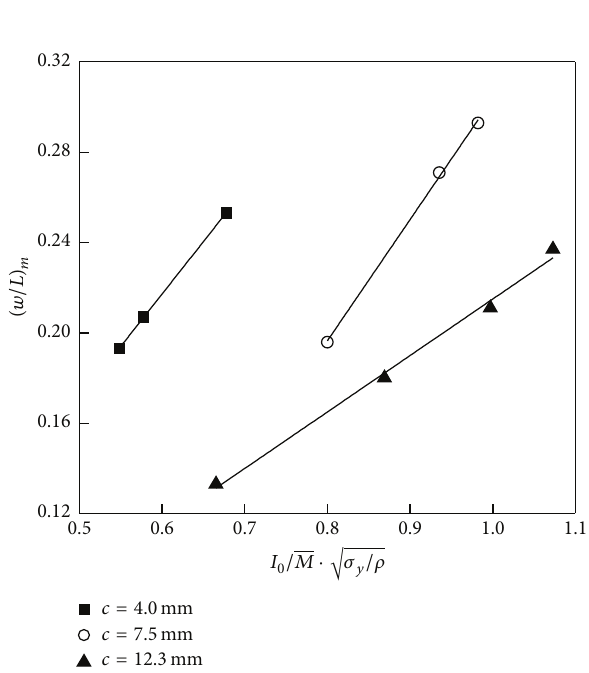
Figure 16: Maximum deflection of the dry face sheets of aluminium sandwich panels as a function of the normalized free-field momen- tum per unit area, 𝐼 𝑠 , for a blast pulse in